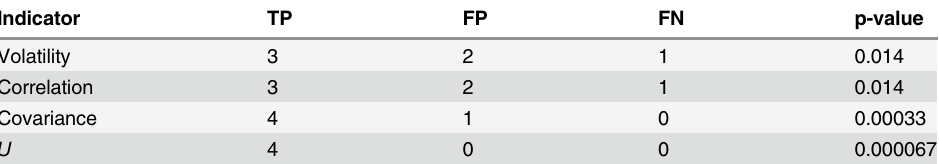
Table 2. Comparison of predictors of market crises. For each predictor (classifier), the table reports the number of true positives (TP), false positives (FP), false negatives (FN), and the probability of obtaining this performance assuming a random